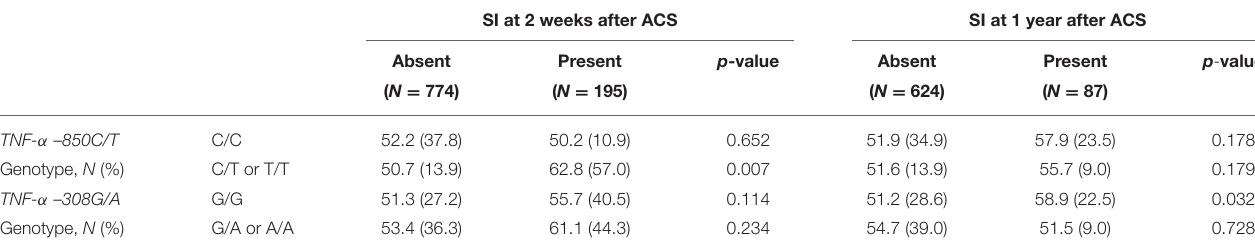
TABLE 2 | Tumor necrosis factor- α (TNF- α ) mean (SD) pg/ml serum concentrations by TNF- α two polymorphisms and depressive disorder status at 2 weeks and at 1 year after acute coronary syndrome